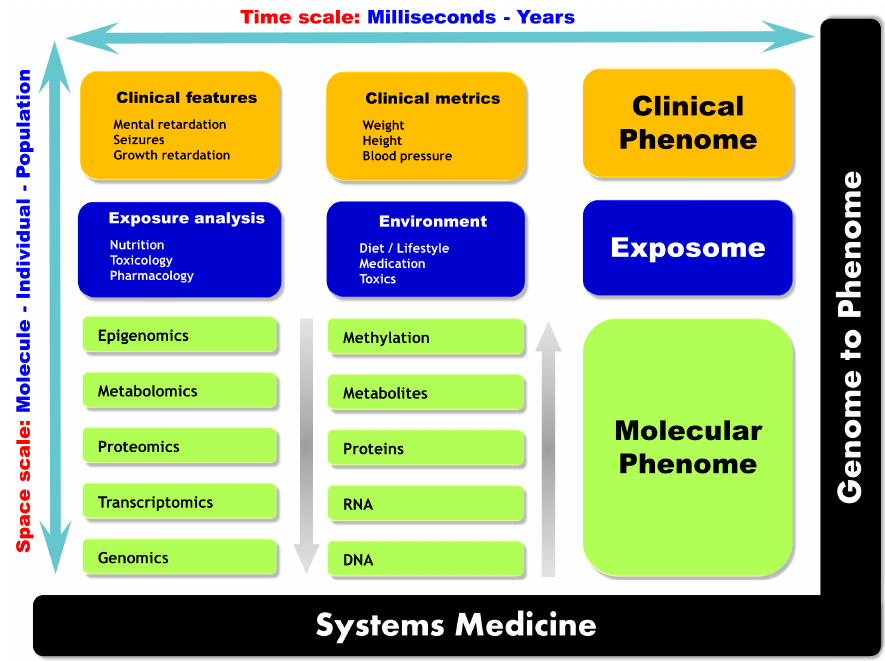
Figure 1. Multi-scale biology overview of systems medicine. Three main drivers define phenotype: (i) the molecular phenome, which is defined by the underlying molecular supports of biological information. The different omics strategies enable to interrogate these supports for information retrieval; (ii) environmental effects spanning from exposures to toxic substances or drugs to diet define the exposome; and (iii) the different clinical metrics used to define the clinical phenome. These different biological and clinical metrics should be approached in a multi-dimensional fashion and should take into account the inherent spatial and temporal scales of both measurement technologies and disease dynamics from the molecular to the population level.